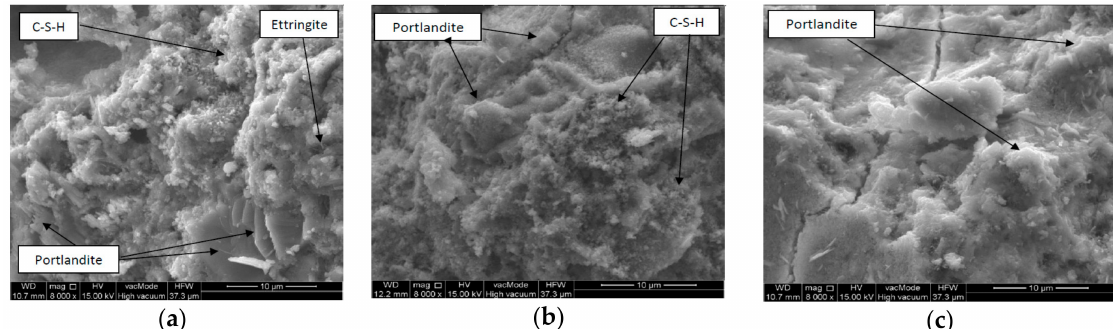
Figure 8. SEM micrograph of sample: ( a ) P10_20, ( b ) P10_400, ( c ) P10_800.